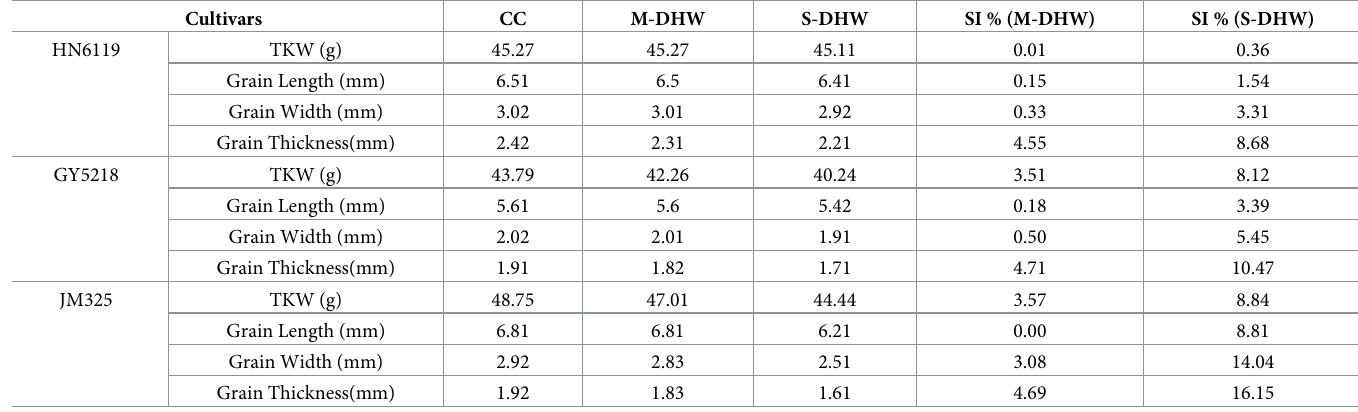
Table 7. TKW (unit: g), grain length (unit: mm), grain width (unit: mm), grain thickness (unit: mm) and SI (unit: %) for the three cultivars under control contrast (CC), mild dry hot wind (M-DHW) stress and severe dry hot wind (S-DHW) stress during the 2020 experiment. Cultivars